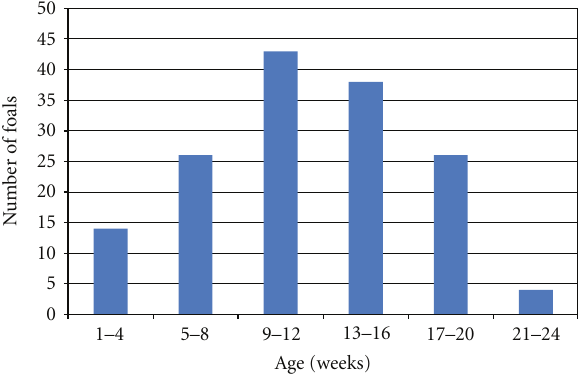
Figure 2: Age distribution of foals